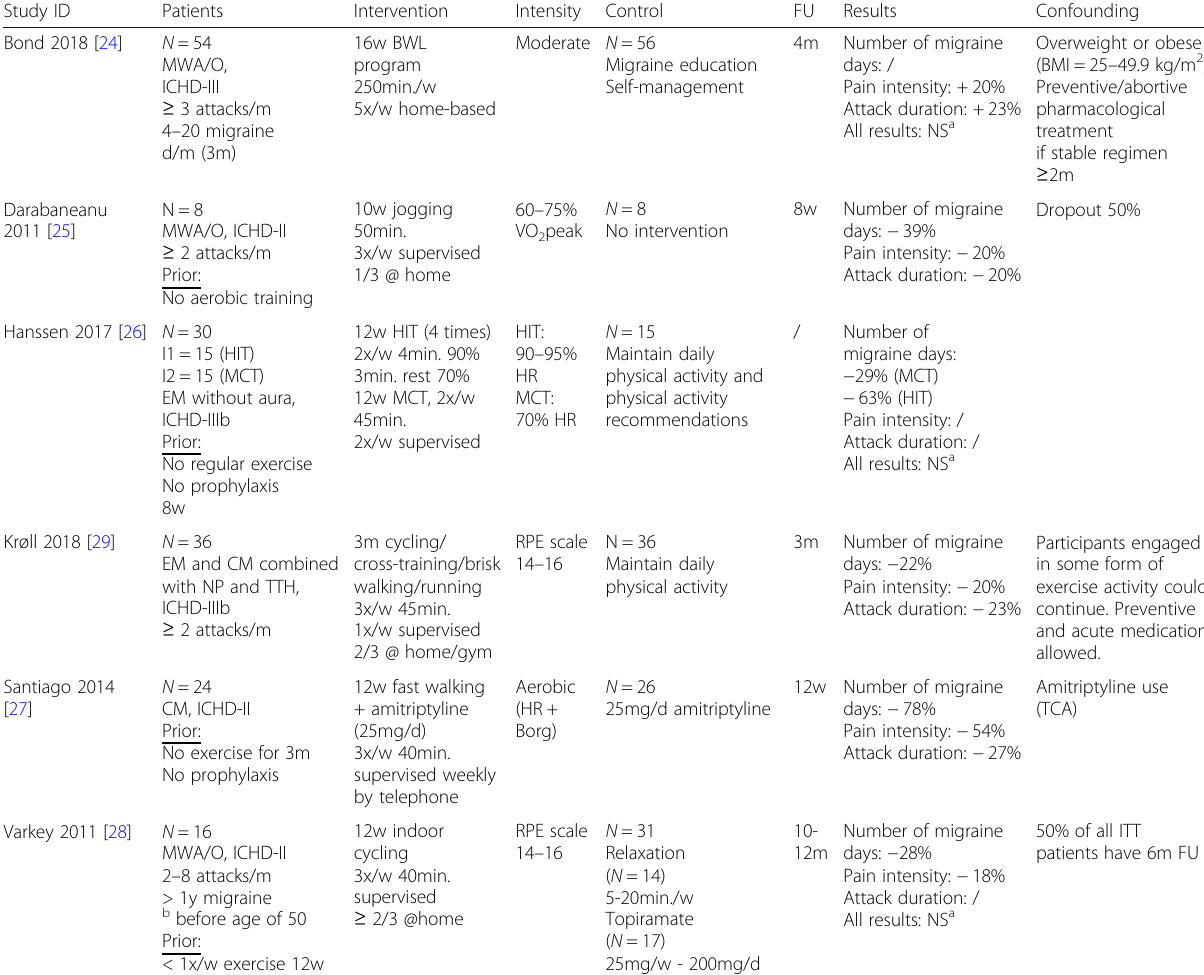
Table 3 Synthesis of results Study ID Patients